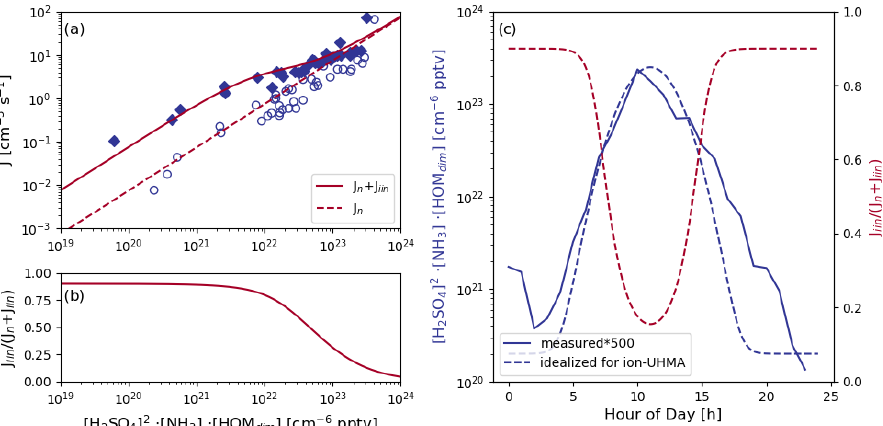
Figure 5. The importance of ion-induced nucleation in the boreal forest. Panel (a) shows the measured nucleation rates (diamonds under galactic cosmic ray conditions and circles under neutral conditions) and the parametrizations (Eqs. 2 and 4). Panel (b) shows the fraction of ion-induced nucleation from total nucleation rate against the parametrizations from Eqs. (2) and (4). Panel (c) shows the diurnal pattern of the calculated nucleation rates and ion-induced fraction in Hyytiälä.